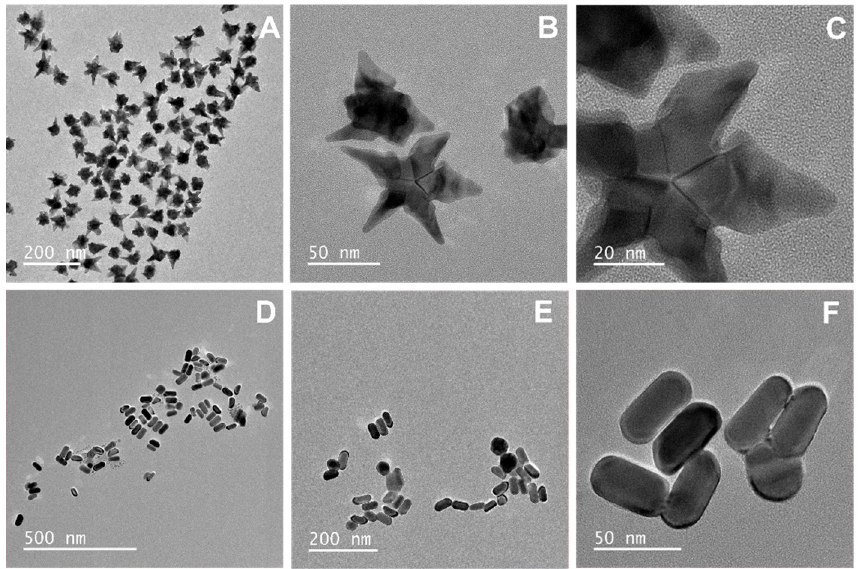
Figure 1. Transmission electron microscopy images of ( A – C ) Au nanostars (GNSs) and ( D – F ) silver coated gold nanorods (Au@AgNRs) at increasing magnifications.